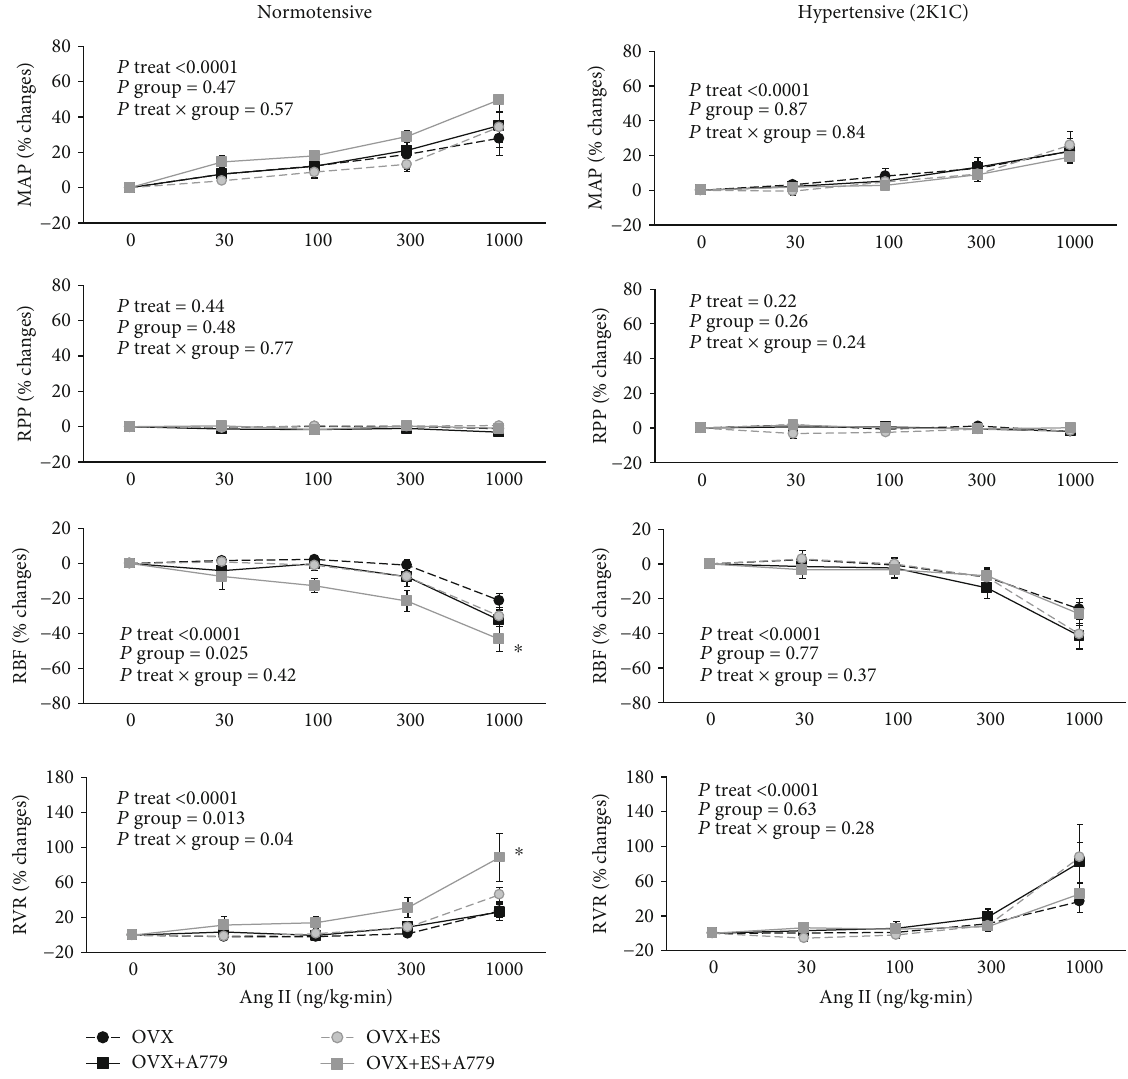
Figure 2: E ff ects of vehicle or A779 on responses to Ang II infusion in two models of normal and 2K1C ovariectomized rats. Data are shown as the mean ± SEM . The data presented as a percentage change from baseline. P value was derived from repeated-measures ANOVA with factors treat, group, and their interaction. ∗ Signi fi cant di ff erence from other subgroups ( P < 0 : 05 ). OVX, ES, and A779 stand for ovariectomized rats, estradiol treatment, and Mas receptor antagonist administration,